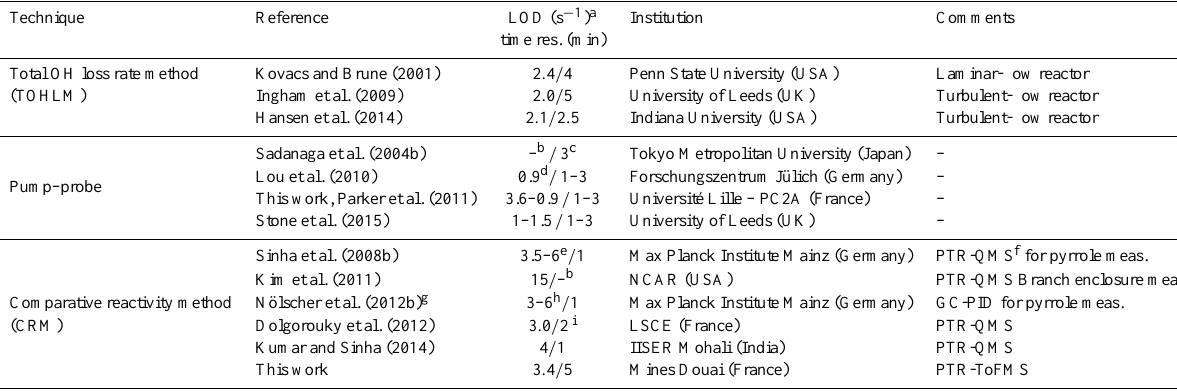
Table 2. Summary of OH reactivity